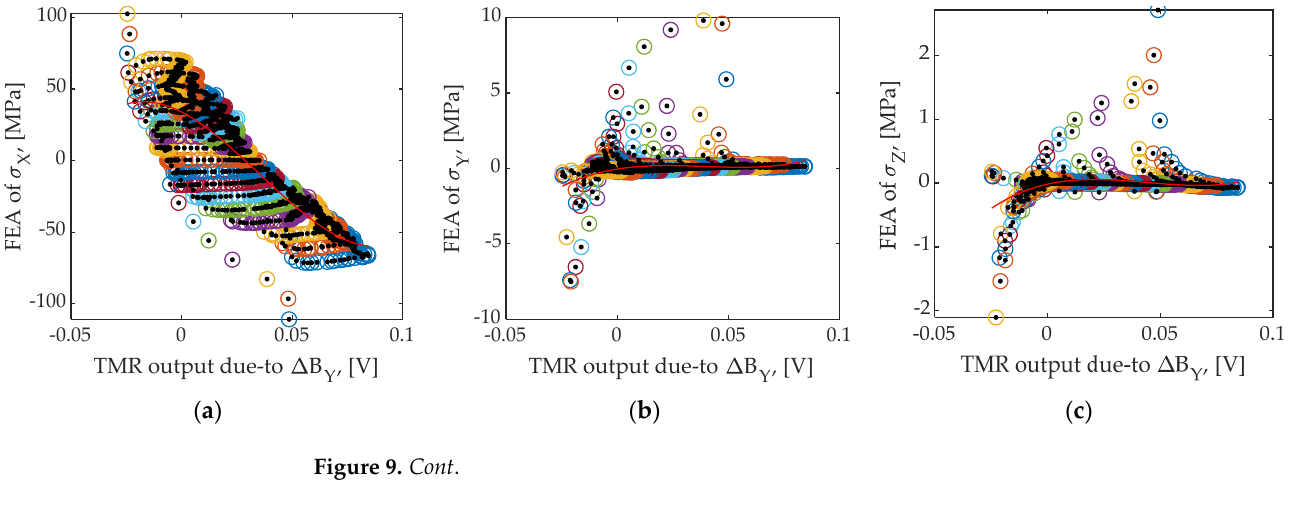
Figure 8. FEM analysis versus experimental results of the differential magnetic flux density ( ∆ B X ) on the area of interest: ( a ) FEM analysis of σ X vs. ∆ B X ; ( b ) FEM analysis of σ Y vs. ∆ B X ; ( c ) FEM analysis of σ Z vs. ∆ B X ; ( d ) FEM analysis of τ XY vs. ∆ B X ; ( e ) FEM analysis of τ YZ vs. ∆ B X ; ( f ) FEM analysis of τ ZX vs. ∆ B X .